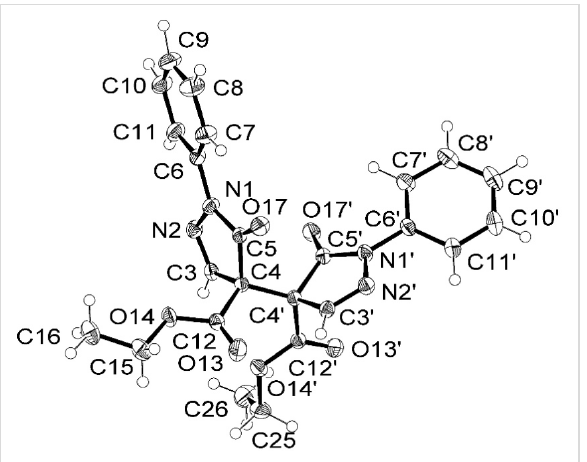
Figure 2: ORTEP-plot of the crystal structure of compound 3a drawn with 50% displacement ellipsoids [(4 S ,4' S )- 3a enantiomer is shown only]. The length of the C4–C4' bond connecting the two pyrazolone units is 1.544(3) Å. For details see the Supporting Information File 1.